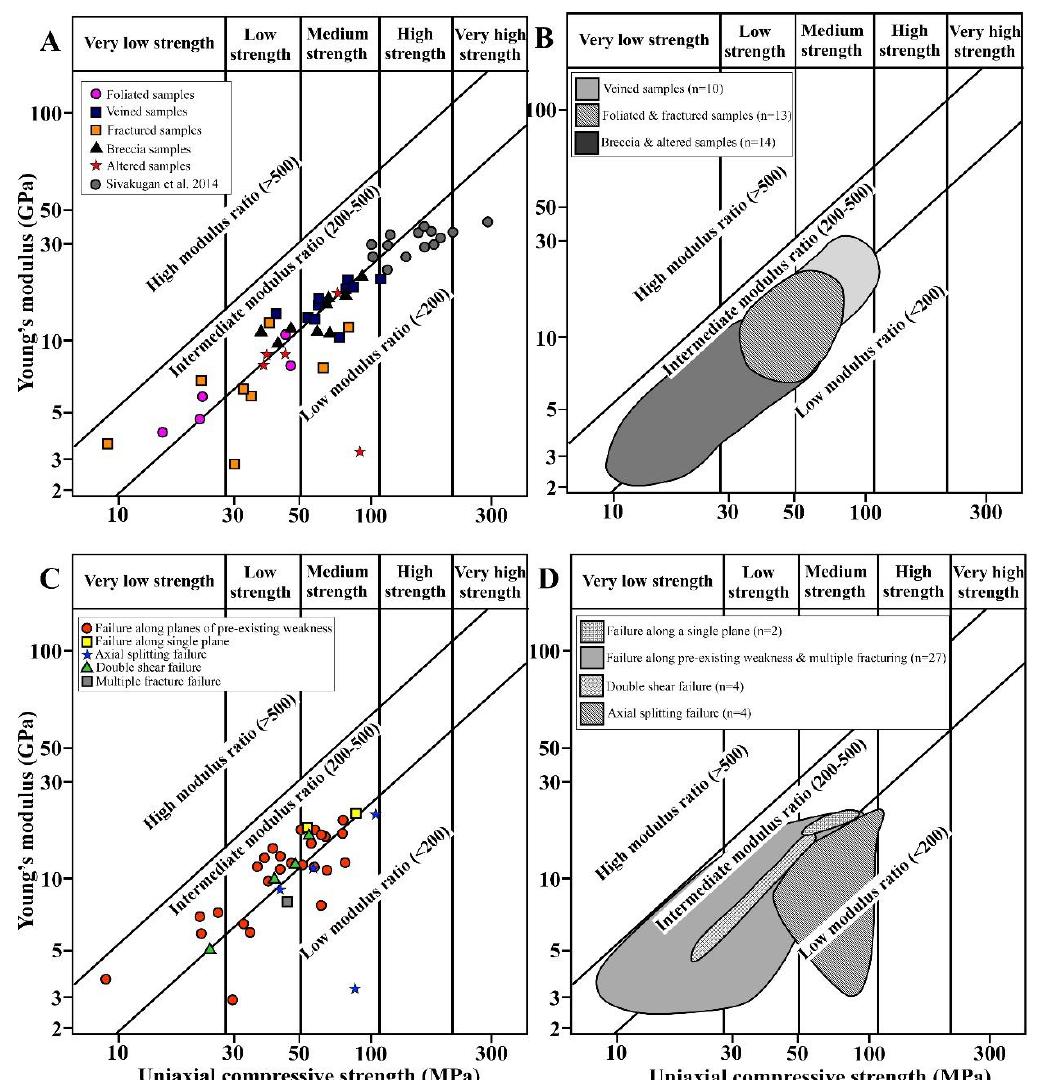
Figure 8. Rock strength classification based on UCS and Young’s modulus. ( A ) Each sample has a colour representing a texture (foliated, veined, fractured, breccia, or altered). Samples [17] plotted in grey illustrate high strength rocks. ( B ) The investigated samples are classified into groups: veined samples, foliated and fractured samples, and breccia and altered samples. The fields are based on the cluster of the samples in ( A ). ( C ) Each sample has a colour representing a different failure mode: failure along a plane of pre-existing weakness, failure along a single plane, axial splitting failure, double shear failure and multiple fractures. ( D ) The samples are classified into four main failure groups. The fields are based on the cluster of samples in ( C ).